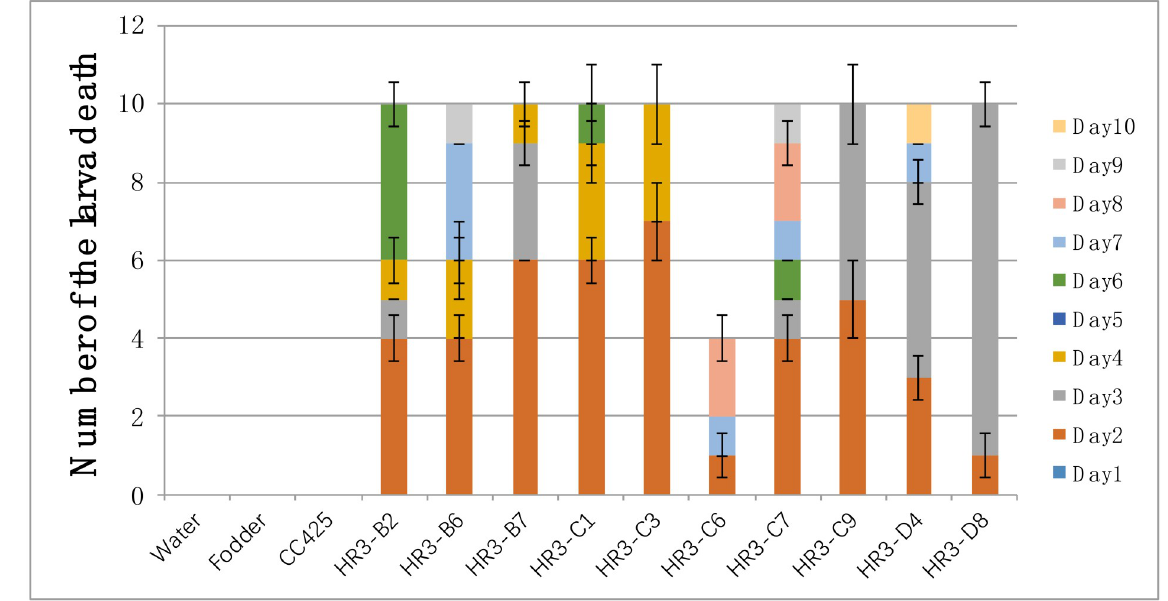
Fig 5. Statistics on the death of the Aedes aegypti larvae fed with HR3 transgenic algae. W: Aedes fed with water; F: Aedes fed with fodder; CC425: Aedes fed with non-transgenic C. reinharditii strain CC425; Maa7: Aedes fed with C. reinharditii CC425 transformed with Maa7IR/ XIR; HR3-B2 to HR3-D8: Aedes fed with Maa7IR/HR3IR transgenic C. reinharditii strains. Note: 10 Aedes larvae per group, repeated 3 times, calculate the average to get the result.